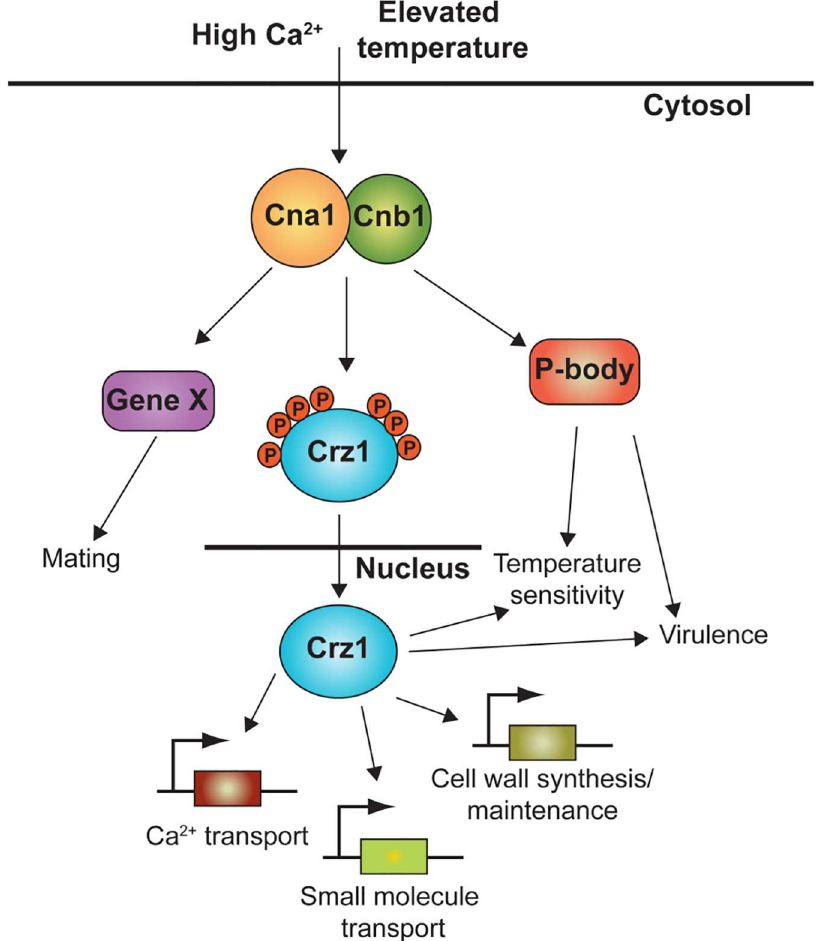
Fig 7. Model of calcineurin-Crz1 signaling pathway in C . neoformans . Under stress conditionssuch as high Ca 2+ concentration or thermal stress, calcineurinis activated and dephosphorylates Crz1, resultingin its translocation to the nucleus. In the nucleus,Crz1 upregulatesthe expressionof stress response genes, such as those involvedin cell wall maintenance or remodelingand small moleculetransport. Calcineurin also translocates to P-bodiesand stress granules[27] where it may act upon other factors that influencemRNA expressionor stability to operate a bifurcated transcriptional/post-transcriptional stress responsenetwork necessary for fungal